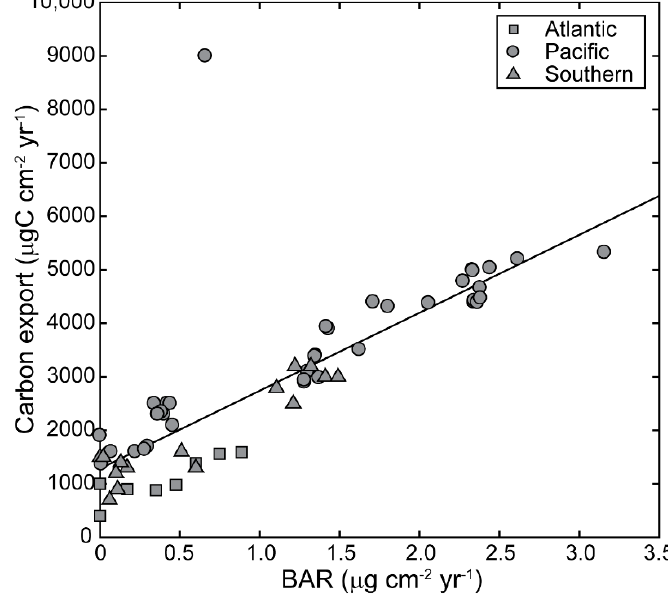
Figure 5. Barite accumulation rates (BAR) versus carbon export. Carbon export values are calculated by applying a region-specific f-ratio to primary productivity estimates. Symbols denote measurements from different ocean basins, the Atlantic Ocean (squares) [100], Pacific Ocean (circles) [44,100], and Southern Ocean (triangles) [100]. The line indicates the global regression for BAR and C export, with an r 2 value of 0.81 [100]. The single outlier, from the Peru Margin, is likely affected by diagenesis, as these sediments are typically anoxic. If the Peru Margin point is not included in the global regression, the r 2 value is 0.89 [100].